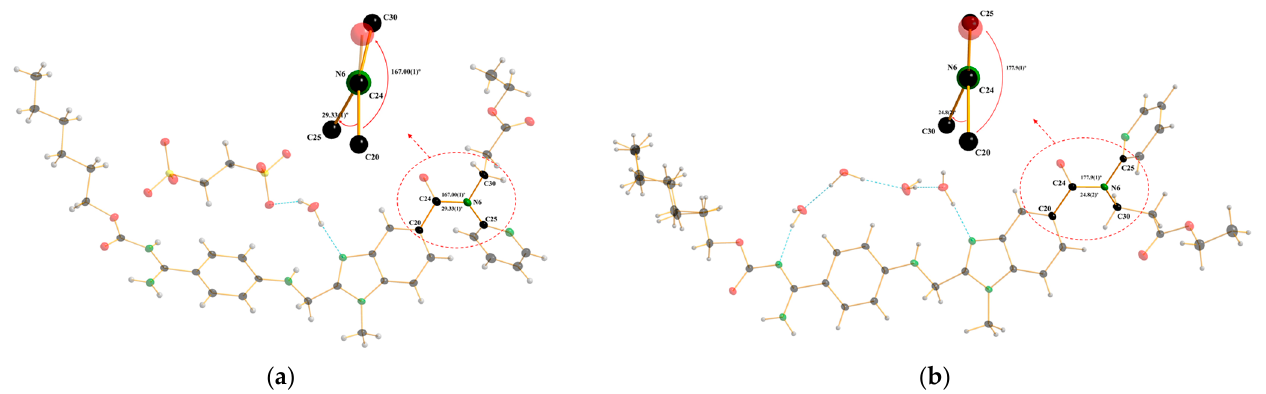
Figure 3. Conformation of DBG molecule with respect to C20-C24-N6-C30 and C20-C24-N6-C25 rotations. ( a ) DBE monohydrate, ( b ) DBG tetrahydrate.